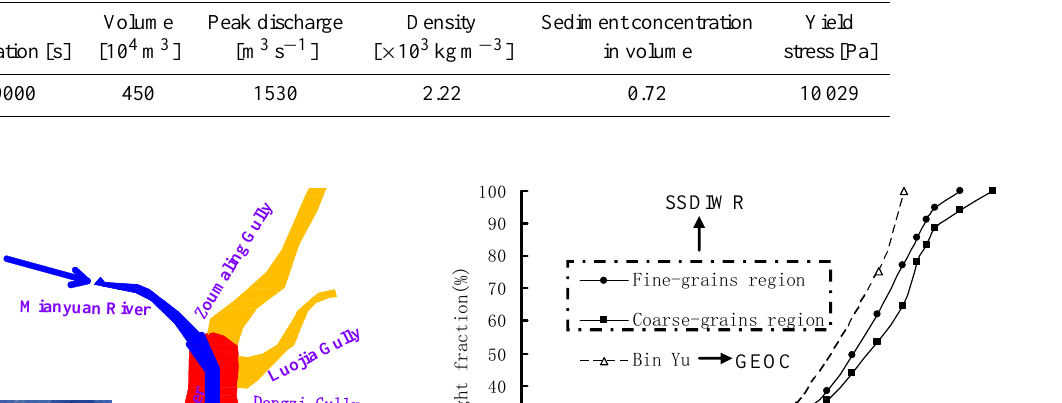
Table 2. Parameters of debris flow.